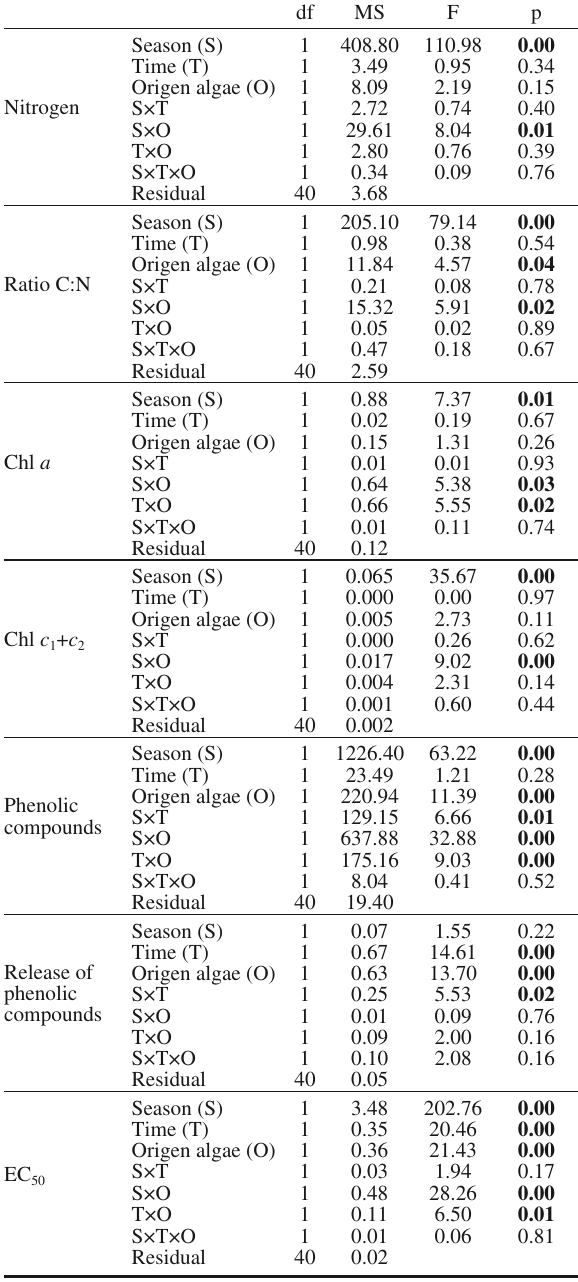
Table 3. – ANOVA results, testing for the effect of Season, Time and Origin of algae (RP; RS) on the total internal nitrogen, C:N ratio, photosynthetic pigments (Chl a and Chl c compounds, phenolic compounds released and EC tamariscifolia . Significant differences at α <0.05 are shown in